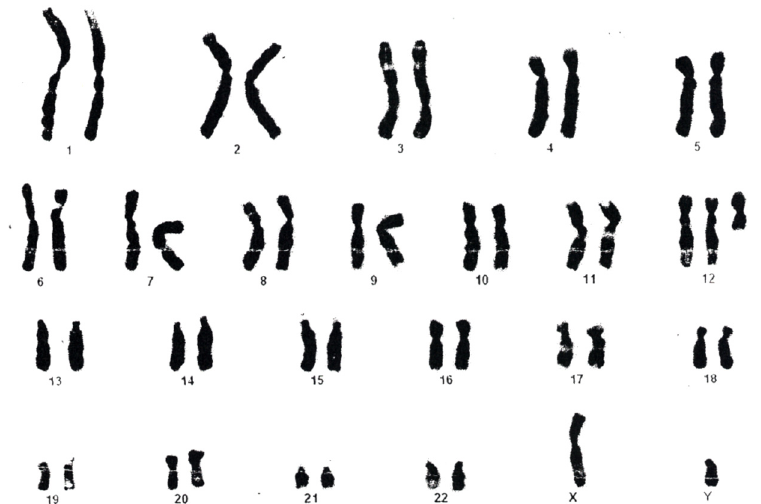
( b ) Figure 4. Clinical features of patient 2: ( a ) 1.5 mo old; ( b ) 16 y old. Brain CT: Symmetric dilatation of basal cisterns and subarachnoidian space, moderate dilatation of the ventricular system. Babygram (1.5 mo old): Hypoplastic humerus, delayed ossification of the cranial vault. The first karyotype (from blood, performed at age 1 y) raised the suspicion of an addition on 22q, and in 1 out of 36 metaphases analyzed an i12p was identified